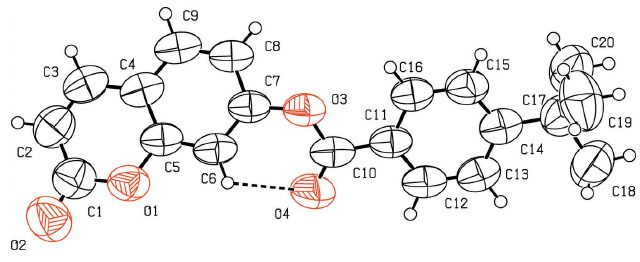
Figure 1 The molecular structure of the title compound and the atomic numbering scheme. Displacement ellipsoids are drawn at the 50% probability level. H atoms are shown as spheres of arbitrary radius. The intramolecular hydrogen bond is indicated by dashed